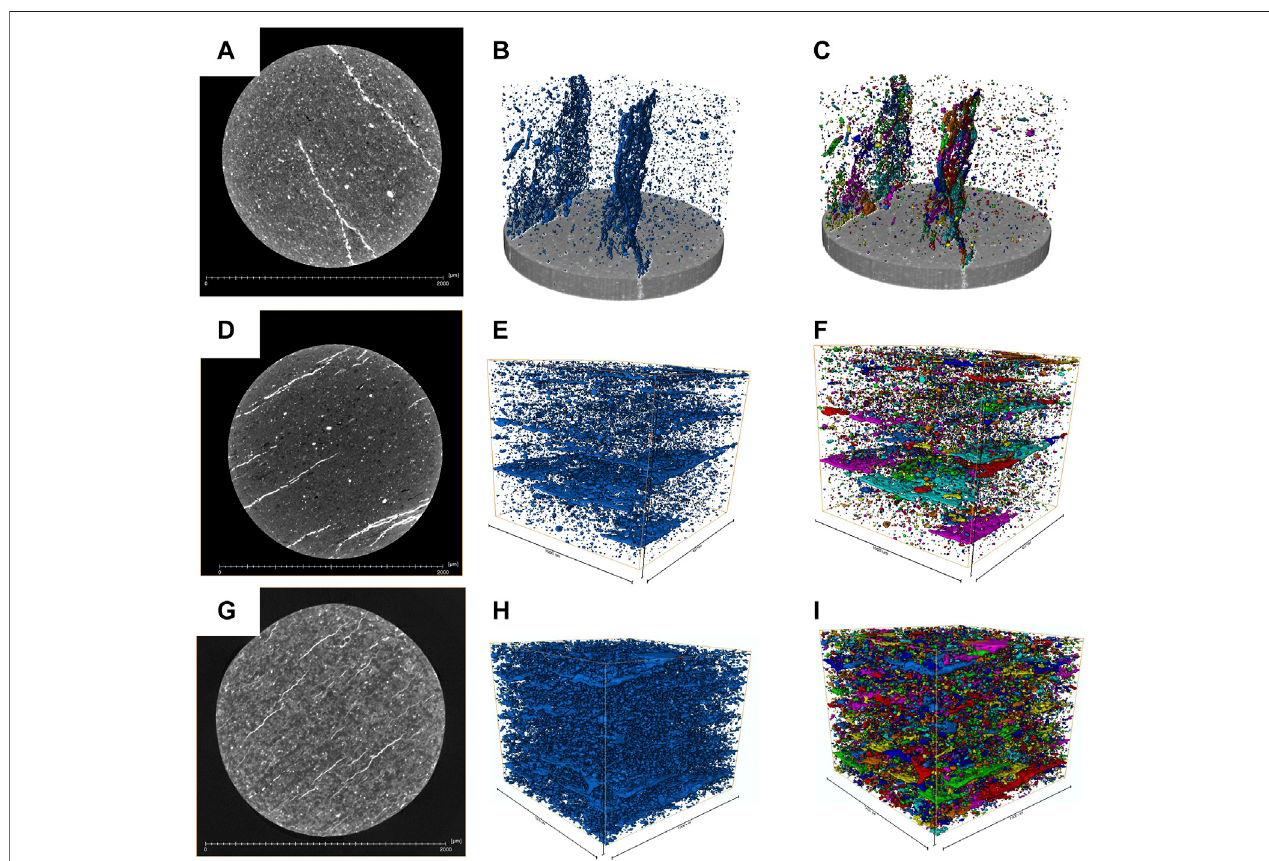
FIGURE8| X-rayCTimagesafterWMinjection. (A , D , G) 2DslicesforsamplesSw-1,JY9,andWY23-6-6perpendiculartothebeddingplane. (B , E , H) Subvolumes with 1000 μ m × 1000 μ m × 1000 μ m at a resolution of 1 μ m. WM reconstructed and volume fractions of WM calculated according to the grayscale threshold segmentation withtheresults of1.2, 0.67, and 7.8%, respectively. (C , F , I) Pore rendering for samplesSw-1, JY9,and WY23-6-6 withdifferentcolors indicating different